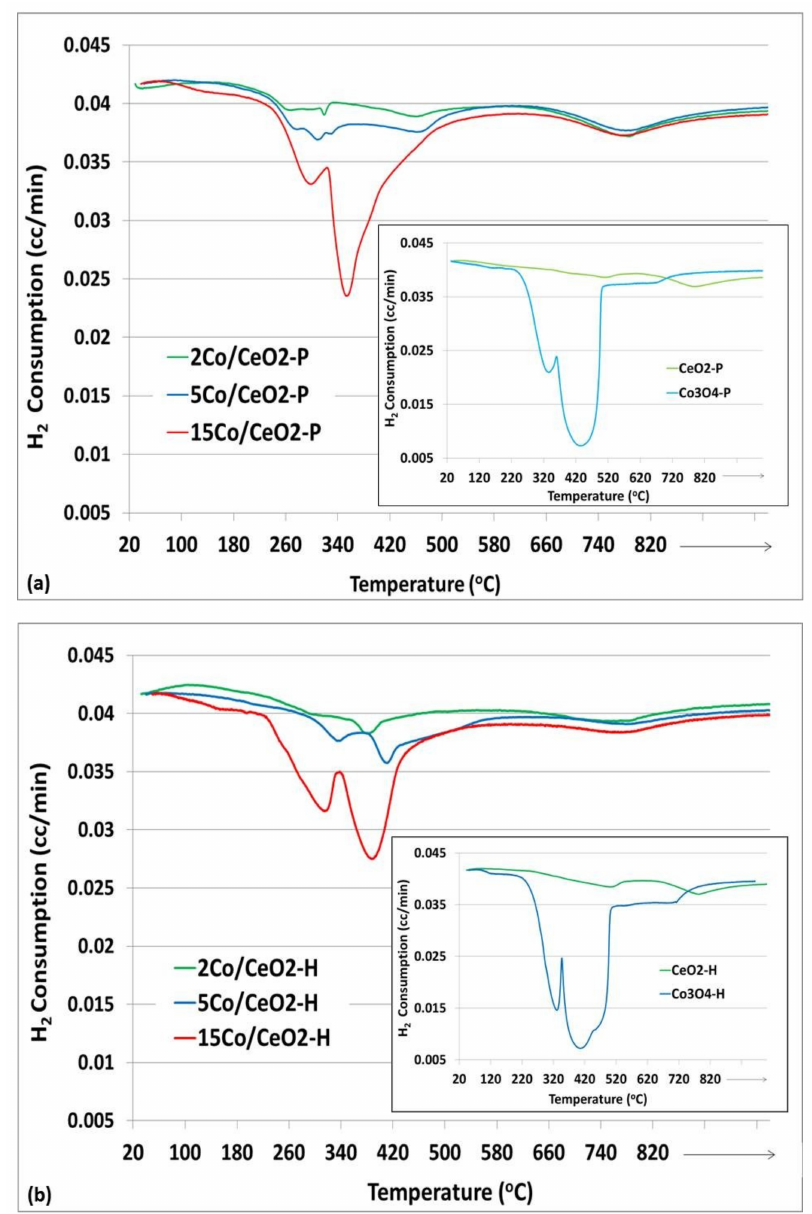
Figure 4. TPR profiles of bare CeO 2 , Co 3 O 4 (insets) and x Co/CeO 2 catalysts prepared with: ( a ) Precipitation and ( b ) Hydrothermal Method. ( x : 2, 5m or 15 wt% Co